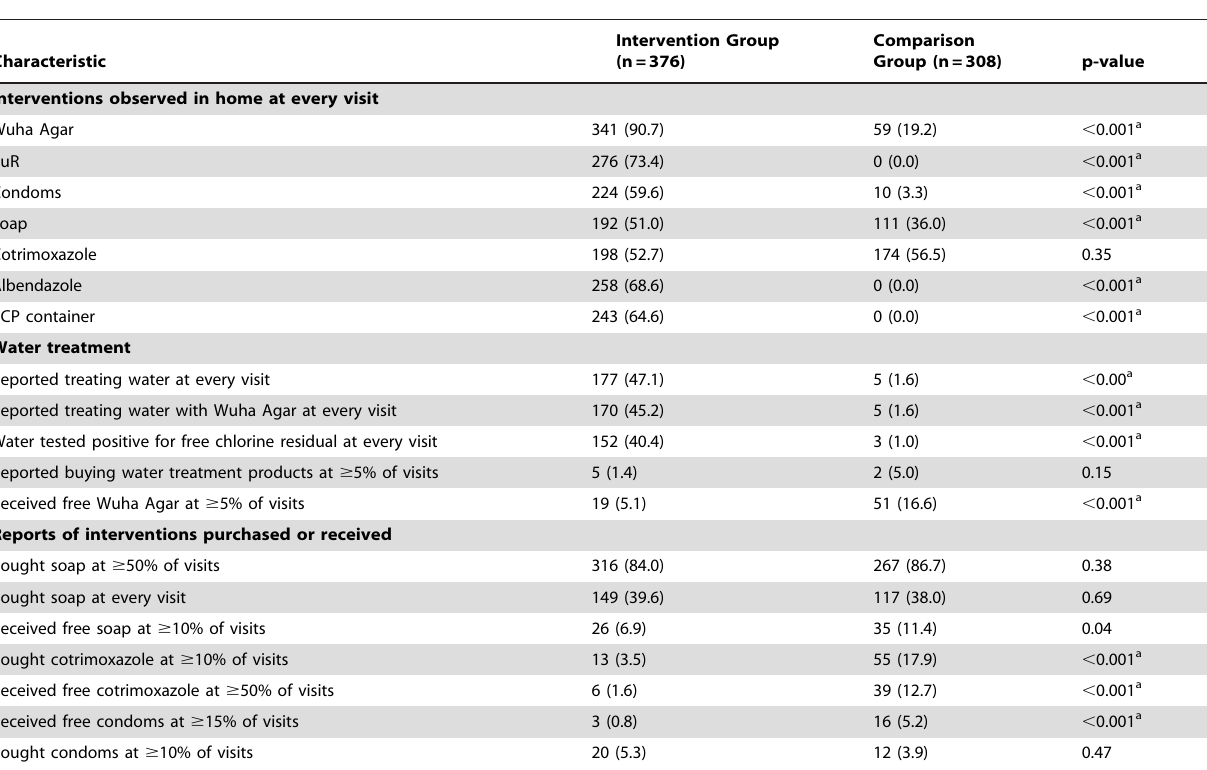
Table 3. Percentage of clients observed to have interventions in the home; reported and observed water treatment behaviors; and reported receipt of interventions, by intervention and comparison group, over 16 weeks of basic care package evaluation, Gonder and Debre Markos, Ethiopia, October 2009–January 2010.